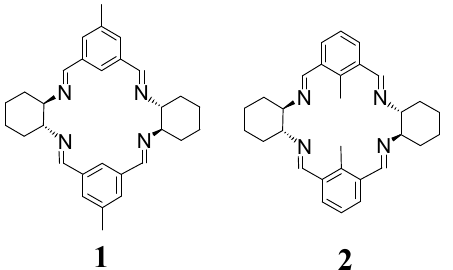
Figure 2. [2 + 2] macrocycles obtained from the kinetic [3 + 3] products.